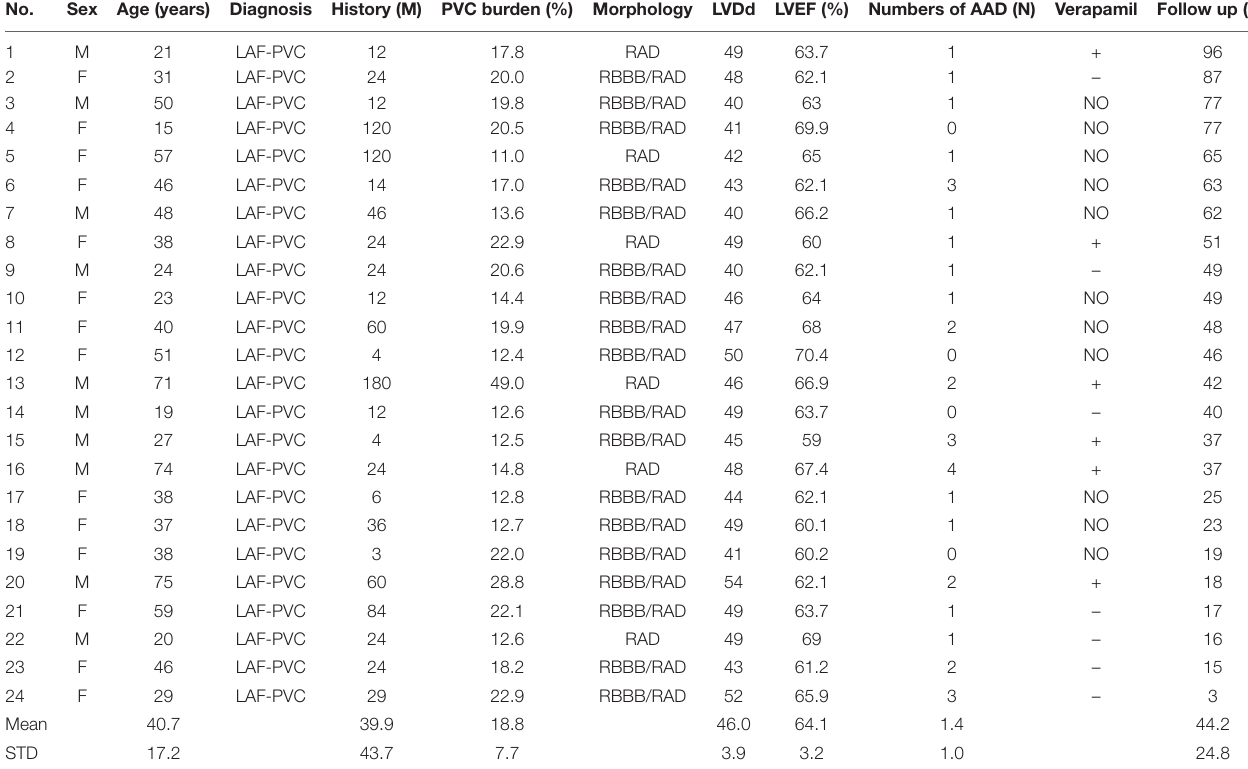
TABLE 1 | Baseline characteristics of patients with premature ventricular contractions originated from the left anterior fascicle.